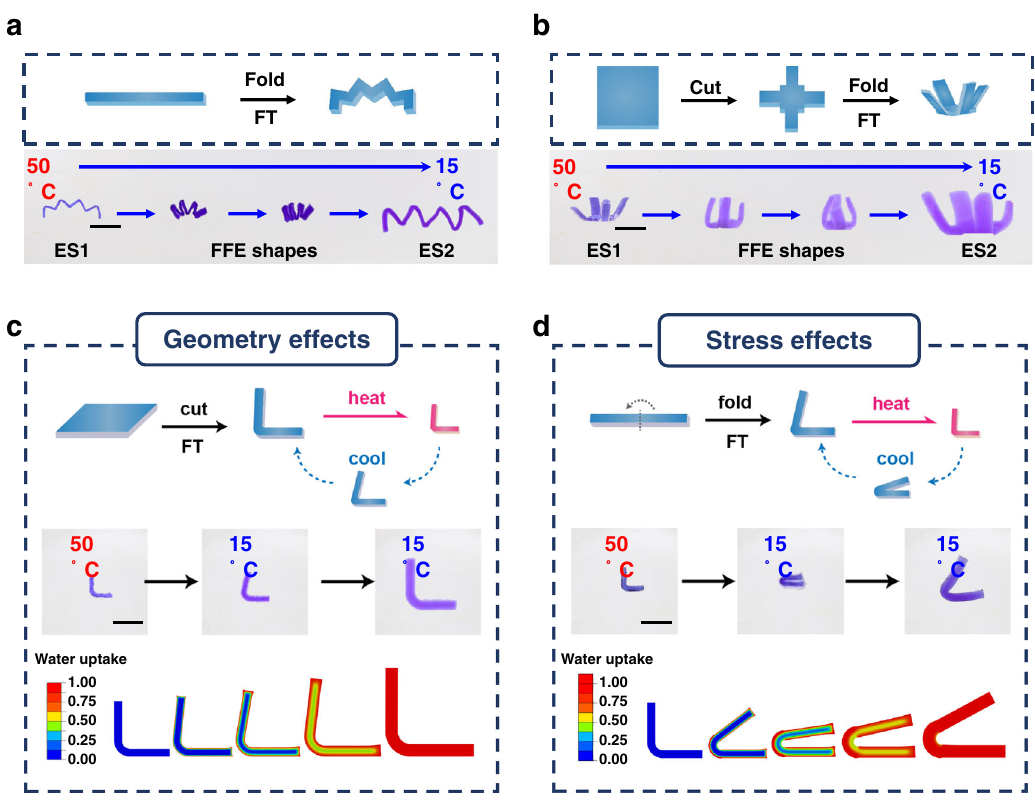
Fig. 2 Demonstration of the FFE behaviors and the underlying mechanism. a , b Programming and FFE behaviors of a a zig-zag and b a four-arm gripper. c , d Illustration, actual images, and FEA modeling of the shape-shifting process for c a stress-free hydrogel and d a stressed hydrogel. Scale bars are all